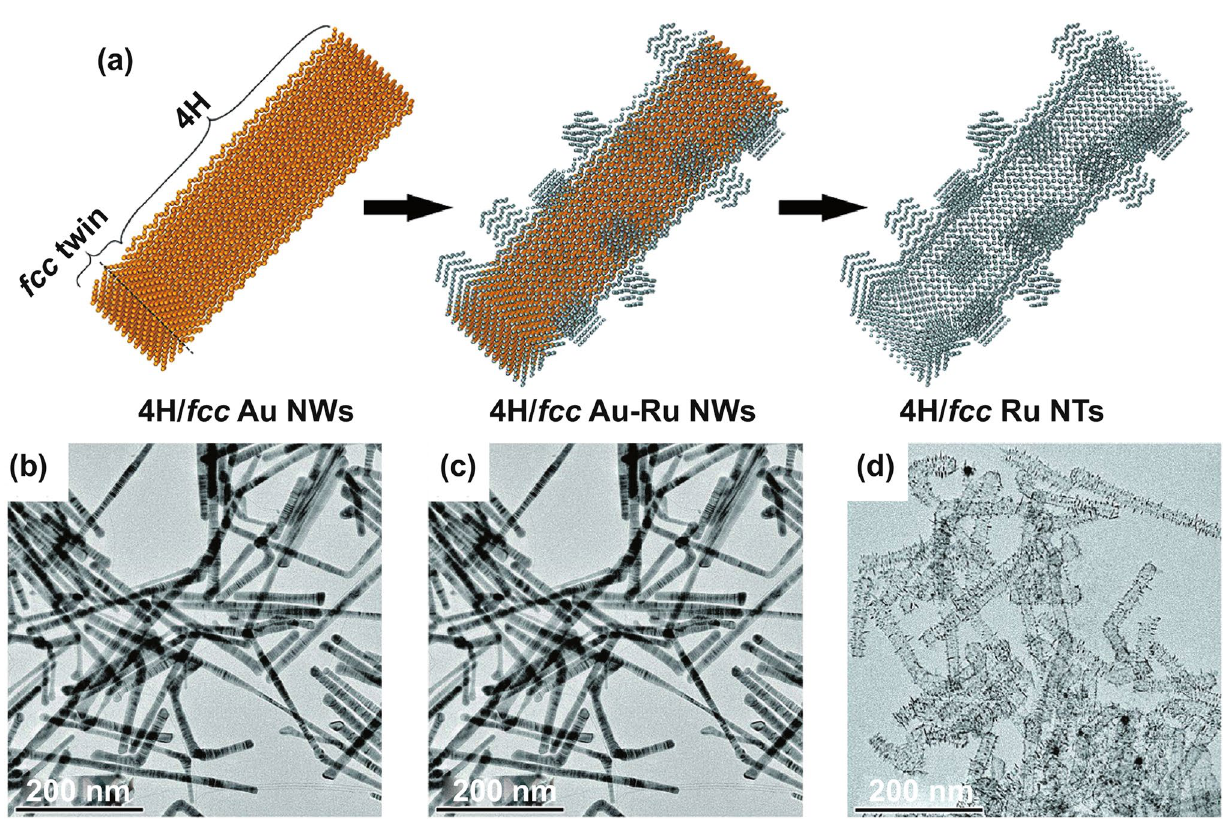
Fig. 6 a Schematic illustration of the synthesis of hierarchical 4H/fcc Ru NTs. b–d Low-magnification TEM images of 4H/fcc Au NWs, 4H/fcc Au-Ru NWs, and 4H/fcc Ru NTs, respectively [83], with permission from the Wiley–VCH Verlag GmbH & Co. KGaA,